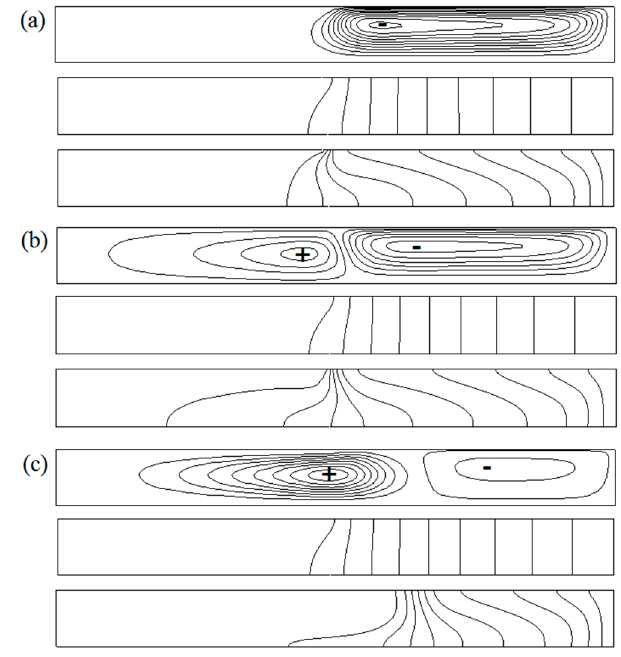
Figure 4. Characteristics of the basic flow when Re T = 400, including the Stream lines (upper), isotherms (middle) and iso-concentration lines (bottom) in the meridional plane. ( a ) Re s = 94, Ψ max( − ) = 0.17; ( b ) Re s = 234, Ψ max( − ) = 0.16, Ψ max(+) = 0.10; ( c ) Re s = 702, Ψ max( − ) = 0.15, Ψ max(+) = 0.87.